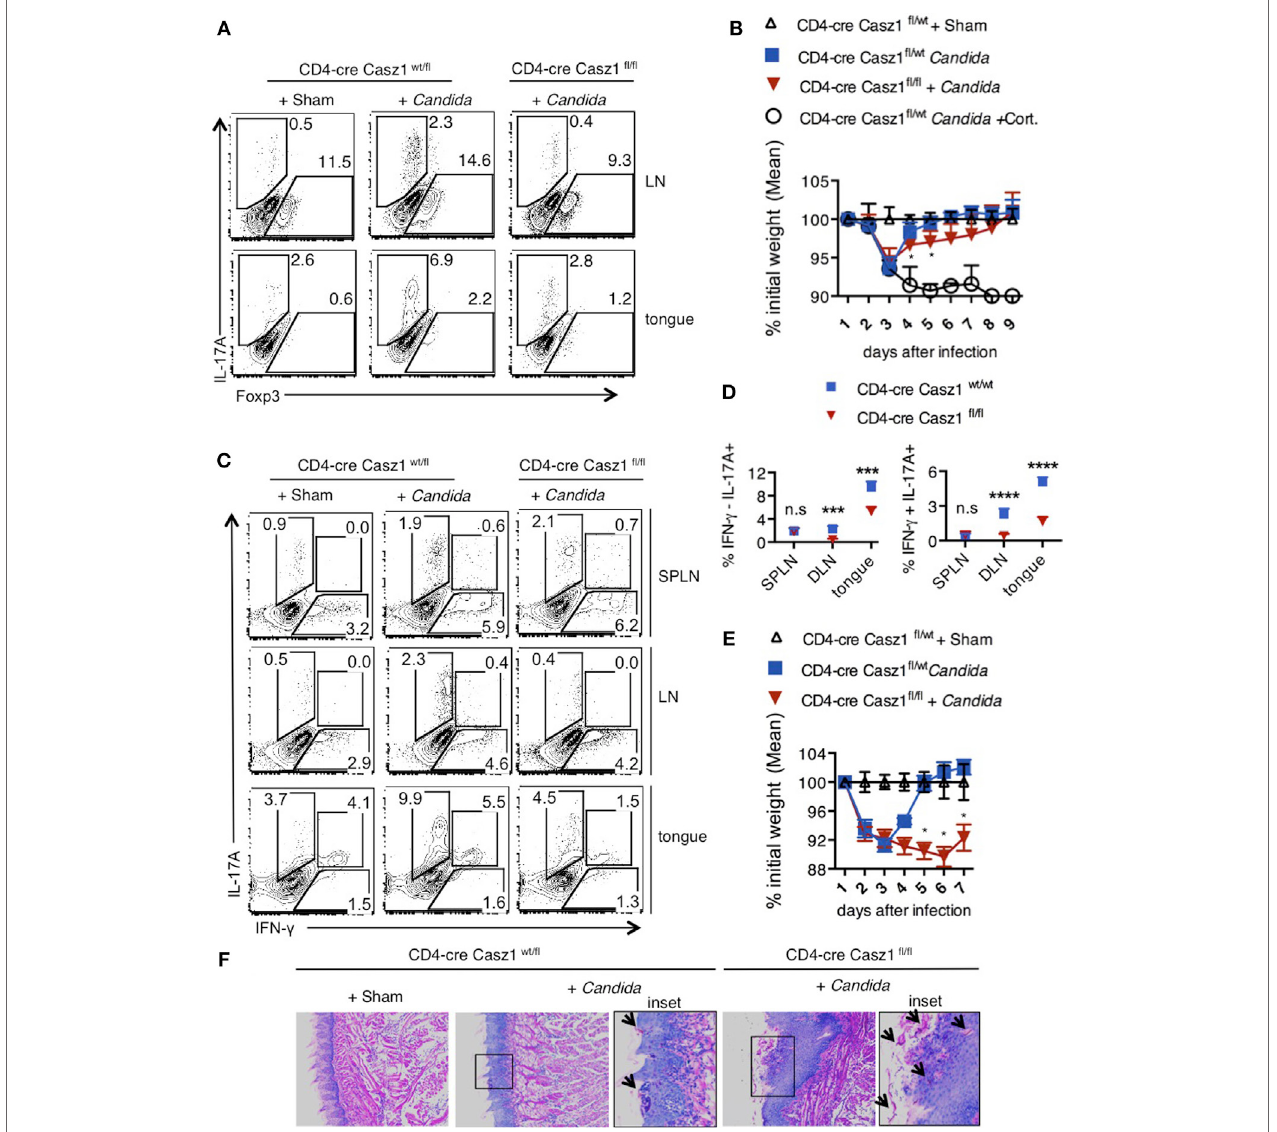
FigUre 5 | Loss of Casz1 impairs IL-17A production and Th17 recall responses during Candida infection in mice. (a) 8- to 10-week-old CD4-cre Casz1 wt/fl ( n = 5) or CD4-cre Casz1 fl/fl ( n = 5) were infected with Candida as described in Methods. Some control mice received PBS (Sham; n = 5) or immunosuppressed with Cortisone injection (Cort; n = 3). Pooled axillary and cervical draining lymph nodes (LN) and the tongues were harvested and restimulated with PMA/Ionomycin on day 3 after primary infection for IFN- γ (X-axis) and IL-17A (Y-axis) staining (gated on CD4 + cells). Data on day 5 showed similar results (not shown). (B) Percent weight change on indicated days after primary infection. (c,D) Mice were infected as in (a) , and re-infected on d21 after primary infection. Two days after reinfection, spleen (SPLN), draining LN, and tongues were processed for flow cytometry. (e) Percent weight change on indicated days after re-infection. (F) On day 5 after reinfection, histology sections of the tongue were stained with periodic acid schiffs to detect the fungus. Microscopic images of the slides that were viewed at 200 × magnification, with insets showing further magnification [arrows show Candida (pink)]. At least five independent experiments, comparing heterozygous with knockout animals, as well as WT with knockout animals showed similar results. Two-way ANOVA test was performed to determine the significance. Gates were drawn using unstain or isotype controls.